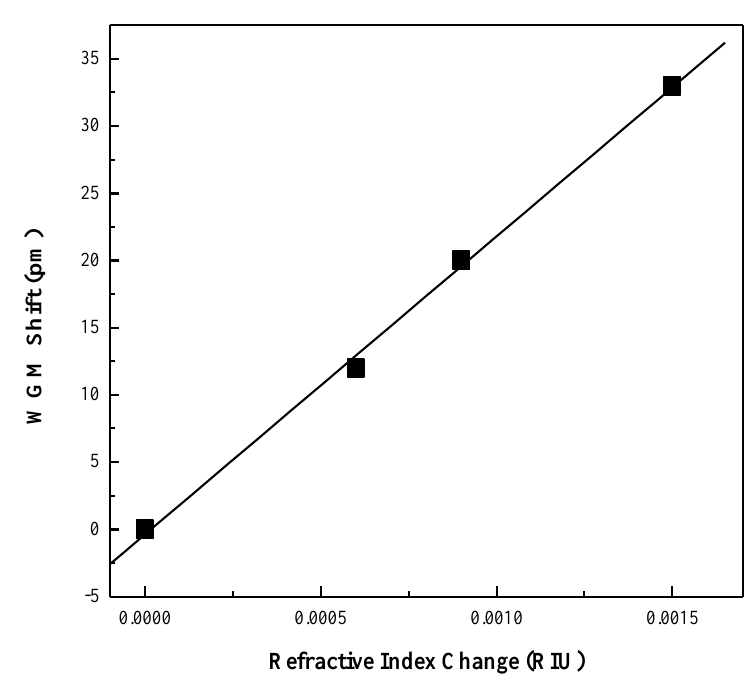
Figure 6. OFRR sensitivity curve with BRIS of 21.9 nm RIU −1